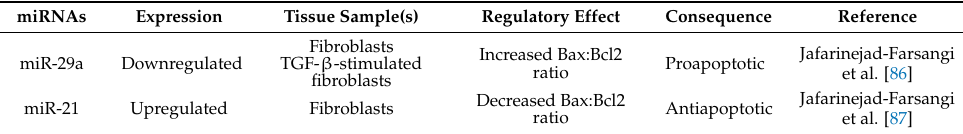
Figure 2. TGF- β 1, the main regulator of fibrosis, plays a central role in SSc pathogenesis. SMAD and non-SMAD TGF- β signaling pathways lead to transcription of fibrosis-related genes responsible for fibroblast proliferation, myofibroblast differentiation, and extracellular matrix deposition. Upregulation (red squares) or downregulation (blue squares) of diverse miRNAs interfere with these mechanisms and promote tissue fibrosis. KLF4: Kruppel-like factor 4; MMP1: matrix metalloproteinase 1; sFRP-1: secreted frizzled-related protein-1; DKK-1: Dickkopf-1; LRP 5/6: lipoprotein receptor-related proteins (LRP) 5 and 6; COL1A1: collagen type 1 alpha 1 chain; COL3A1: collagen type 3 alpha 1 chain; TAB1: transforming growth factor beta activated protein kinase 1; TGFR1: transforming growth factor beta receptor 1; TGFR2: transforming growth factor beta receptor 2; Wnt: Wnt signaling pathway; alpha-SMA: alpha-smooth muscle actin; CTGF: connective tissue growth factor; TIMPs: tissue inhibitors of metalloproteinases; IL-13R alpha 1: interleukin-13 receptor alpha 1; IL-4R alpha: interleukin-4 receptor alpha; STAT6: signal transducer and activator of transcription 6. Table 3. Apoptosis and